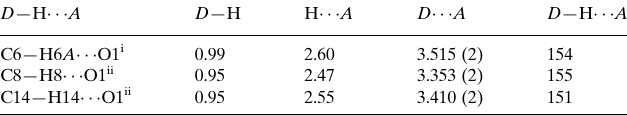
Hydrogen-bond geometry (A˚ , (cid:2)